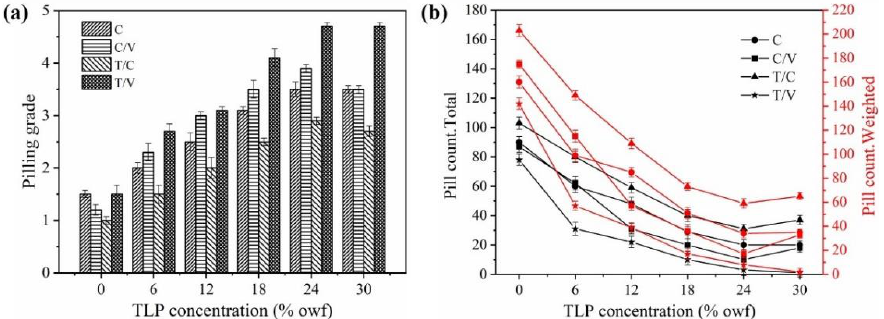
Figure 2. Pilling grade ( a ) and pill count ( b ) of fabrics treated with the dipping process at various TLP concentrations.